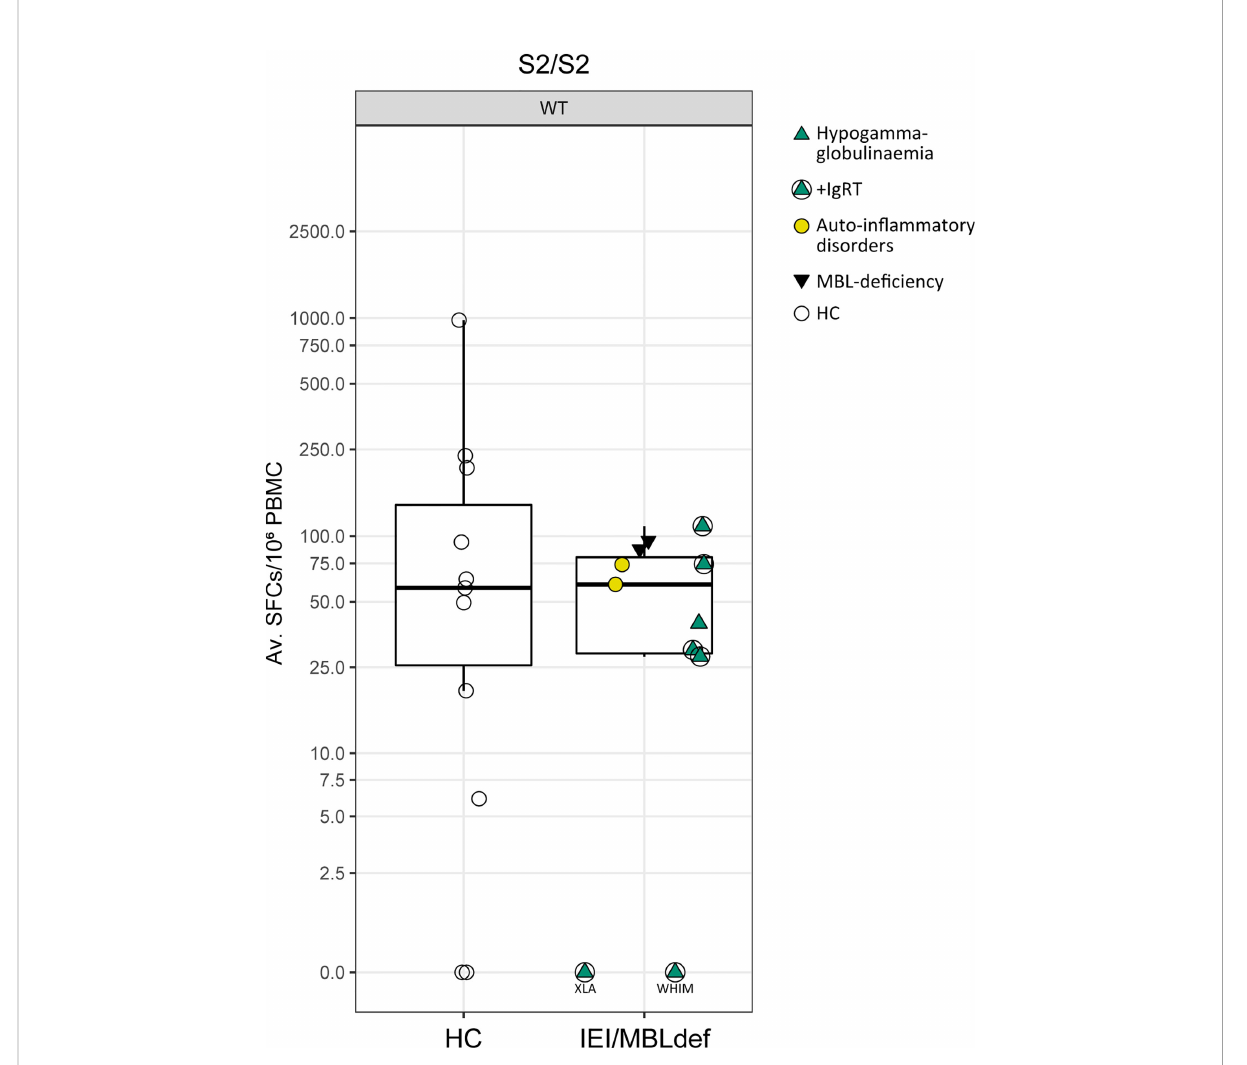
FIGURE 3 SARS-CoV-2 speci fi c T-cell responses. SARS-CoV-2 speci fi c T cell responses were detected by ELISpot assay from peripheral blood mononuclear cells (PBMCs) stimulated with wild type (WT) spike unit S1 and S2 peptide pools after the second vaccination. Composite ELISpot results from 11 patients and 11 HCs; Av SFCs/10 6 PBMC: Average of spot-forming cells per 10 6 peripheral blood mononuclear cells. Circles: healthy controls, green triangles: patients with hypogammaglobulinemia. Patients receiving IgRT are marked with circles. Yellow circles: patients with auto-in fl ammatory disorders. Black inversed triangles: patients with MBL de fi